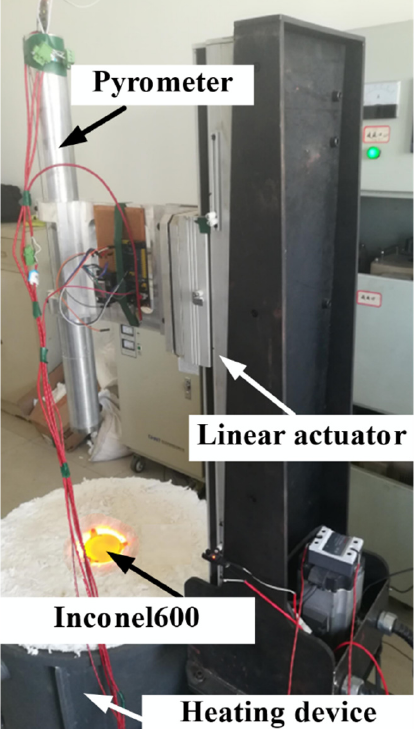
Figure 4. Schematic diagram of the structure of experimental device.